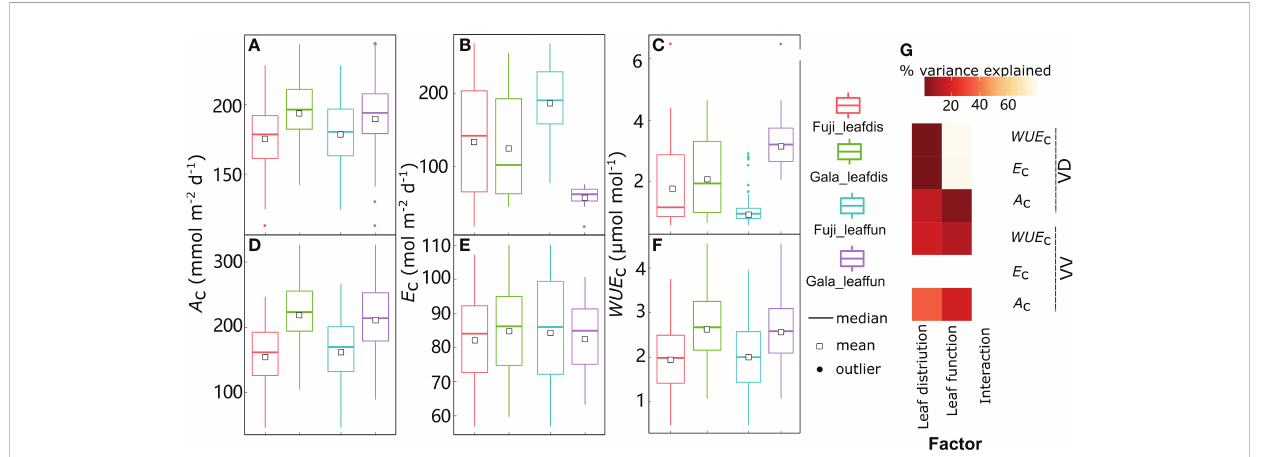
FIGURE 9 Boxplot of daily canopy net photosynthesis rate ( A c ) (A, D) , transpiration rate ( E c ) (B, E) , and water use ef fi ciency ( WUE c ) (C, F) in dwarf interstock (VD) or vigorous interstock (VV) trees with switching cultivar leaf distribution ( leafdis ) and leaf function ( leaffun ) under sunny conditions, and corresponding amount of variances explained by cultivar leafdis , leaffun and their interaction (G) . The percent variance explained by each factor in the model is indicated using color for those factors that explain a signi fi cant portion of the variance ( p < 0.05) and different letters indicate signi fi cant differences at p < 0.05.